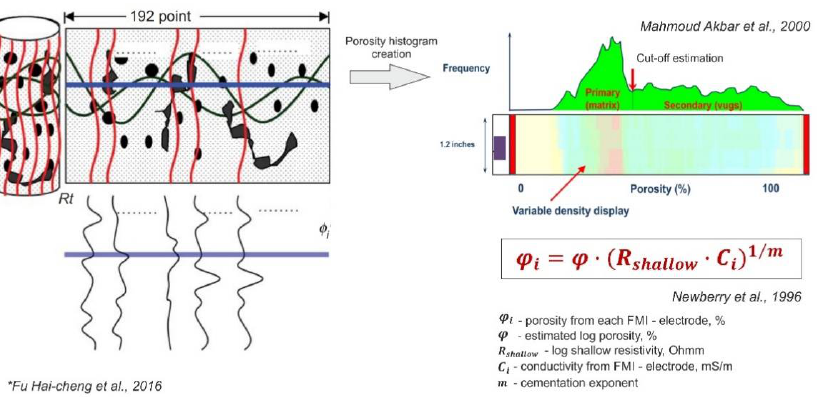
Figure 7. Calculation of the porosity spectrum from borehole images. Top right panel: x-axis = porosity distribution; y-axis = frequency. Bottom left panel: sketch map of the button-electrode conductive curves. Top left panel: the dimension of the figure is 192 points in the FMI. Black dots: vugs, dark green sinusoids: fractures, red vertical lines: button-electrode conductive curves, dark blue horizontal line: reference level for porosity histogram calculation, which is estimated at each depth of the FMI survey.